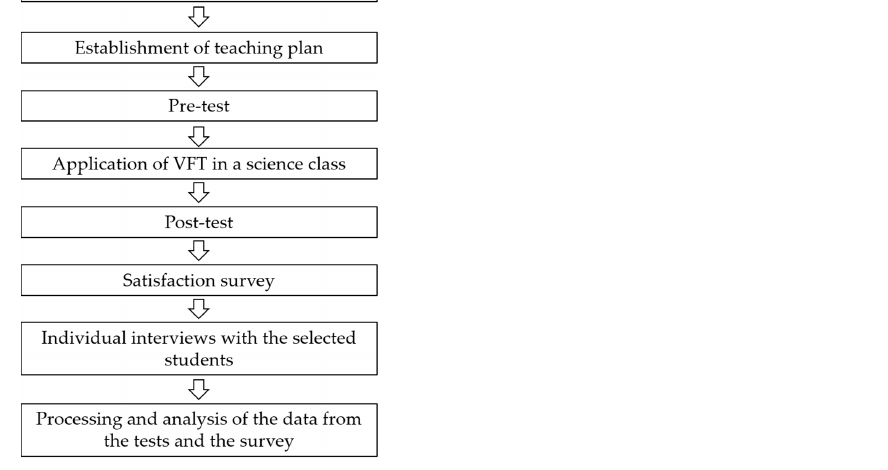
Figure 5. Overall flowchart of the study process on the Bangnyeong Island